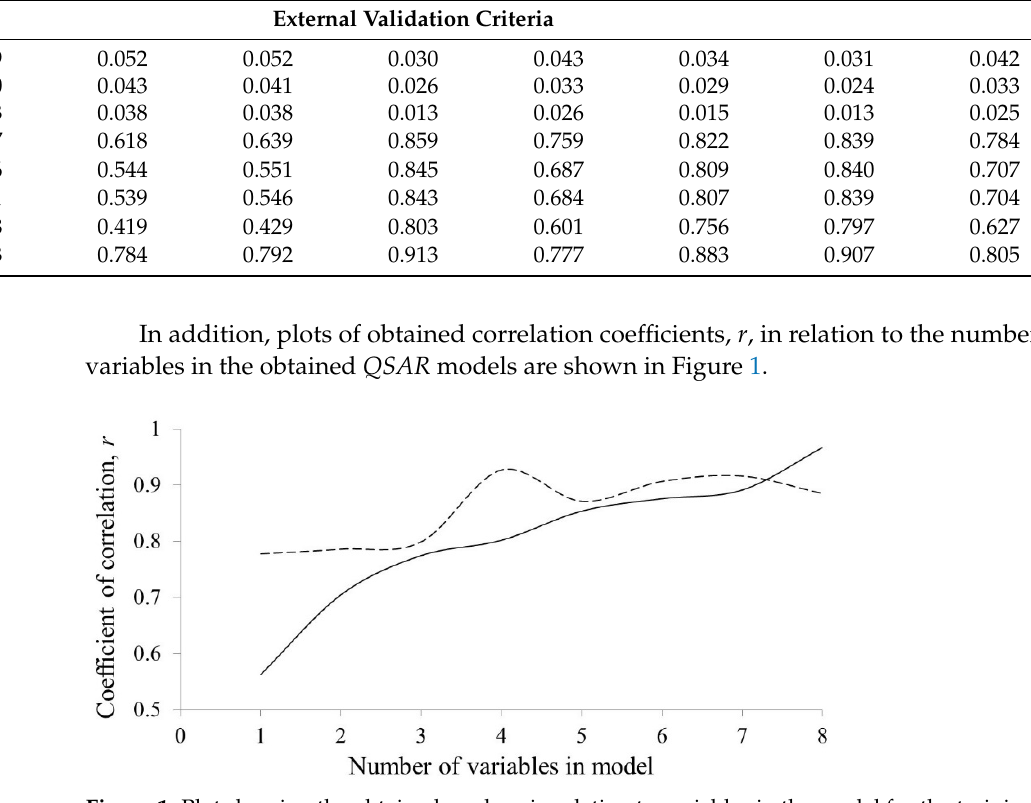
Figure 1. Plot showing the obtained r values in relation to variables in the model for the training set (full line) and test set (dashed line).